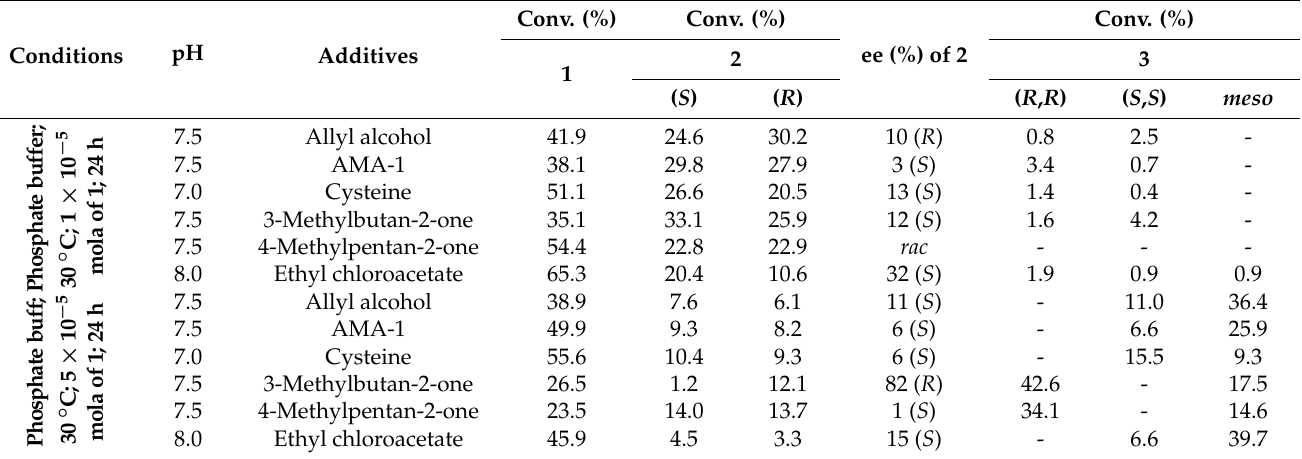
Table 11. Deracemization of Rac- Benzoin ( 2 ) and Bioreduction Catalyzed by A. pullulans Strain DSM 14940 and DSM 14941 in Phosphate Buffer with